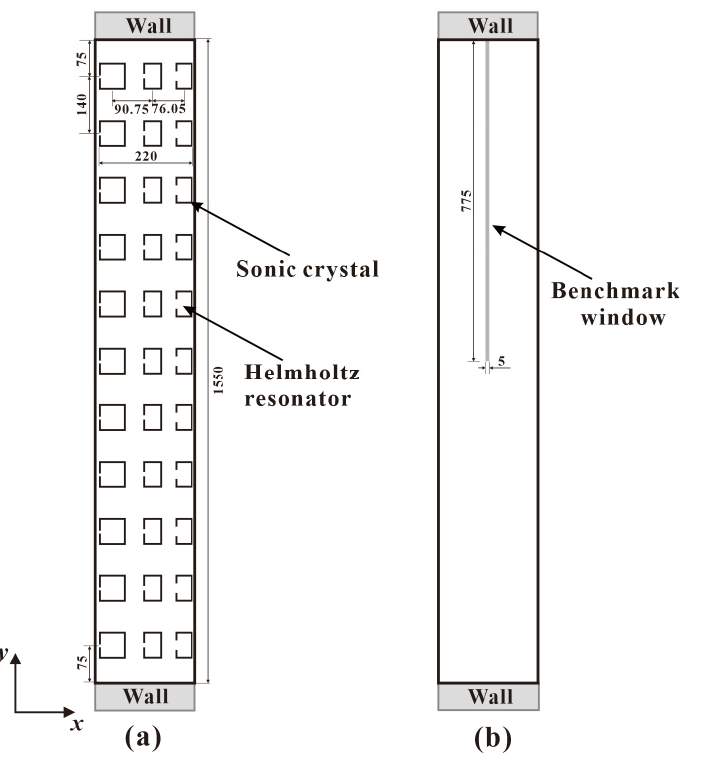
Figure 5. Schematic diagram of the tested windows: ( a ) LRSCs window, ( b ) Benchmark window (units: mm).